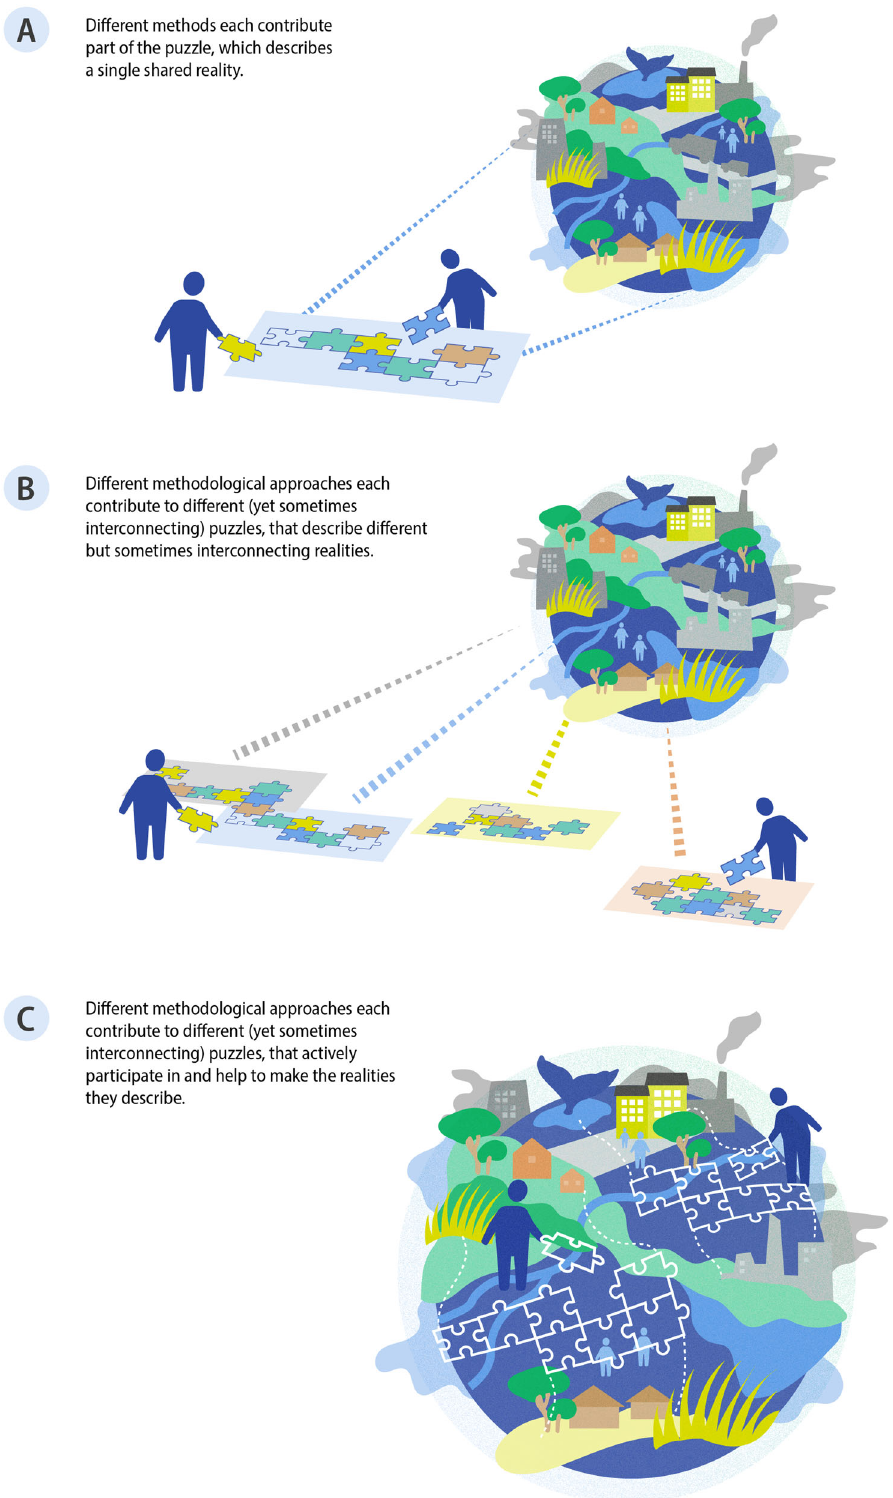
Fig. 1 Changing understandings of research methods. A It illustrates the view that different research methods each provide their own ‘ puzzle pieces, ’ which can all be fi tted together to provide a clearer picture of reality. B It adds complexity to this view, by highlighting the presence of different methodological traditions with differing and sometimes incommensurable assumptions. C It adds further complexity still by suggesting that these differing traditions do not simply describe different realities but also inevitably participate in and help to create the realities they describe. Illustration by Elsa